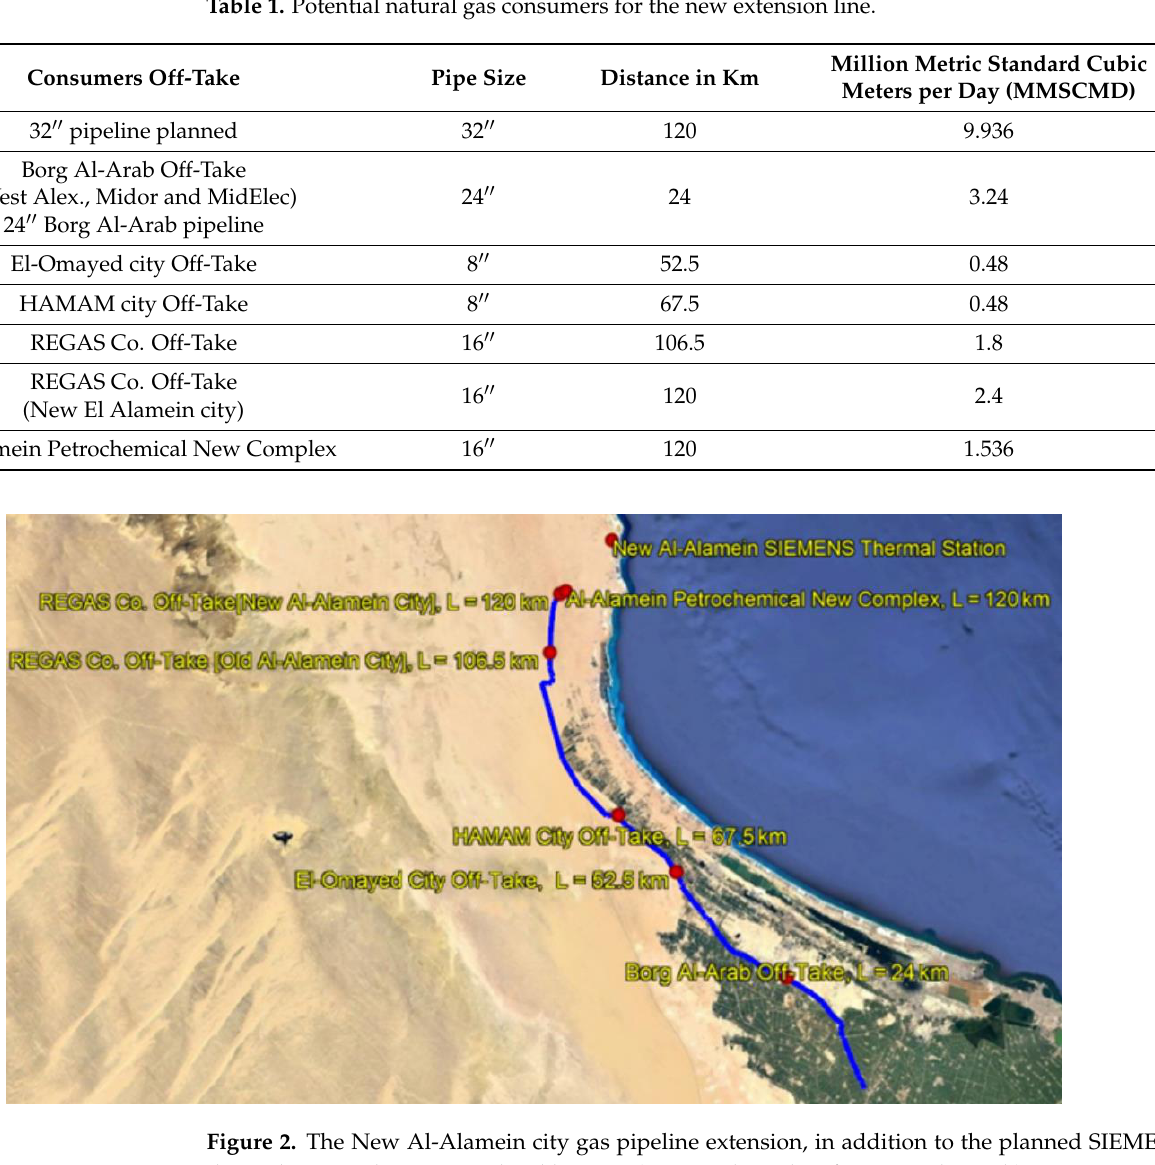
Table 1. Potential natural gas consumers for the new extension line.